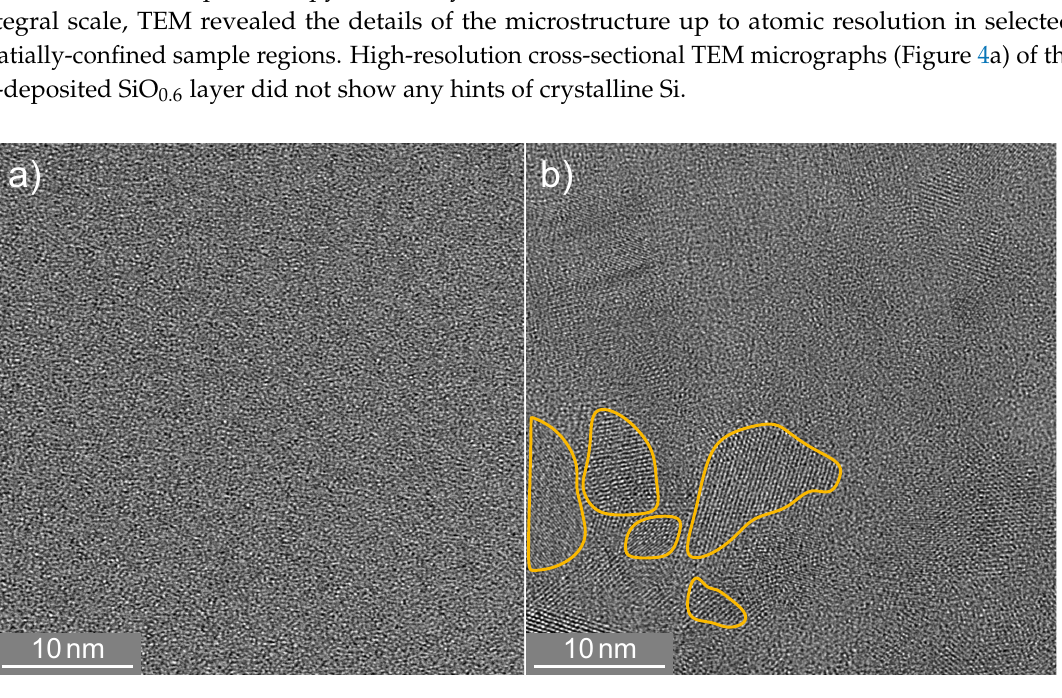
Figure 4. High-resolution TEM image of SiO 0.6 layers: as-deposited ( a ) and after conventional oven treatment ( b